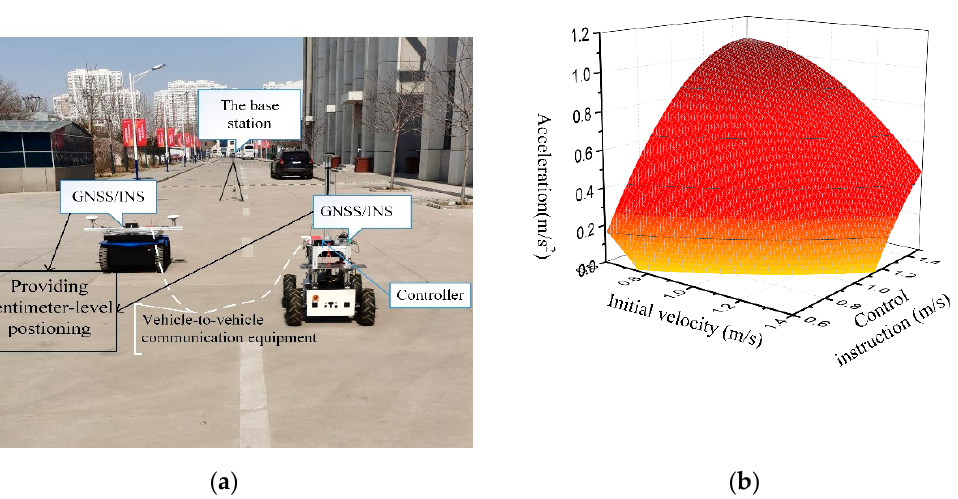
Figure 9. ( a )Experimental system; ( b ) Acceleration–elocity conversion diagram at different vehicle velocity.